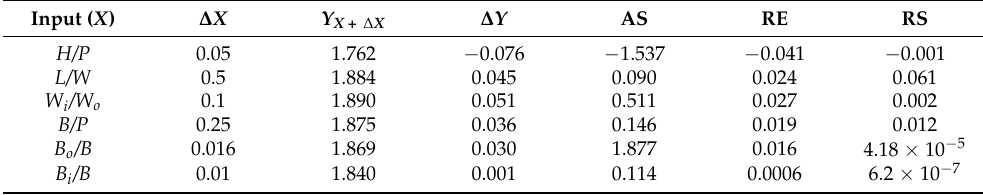
Table 7. Sensitivity and error analysis ( X is an input parameter, ∆ X is a 10% increase in X , and ∆ Y is a change in the output ( C D ).